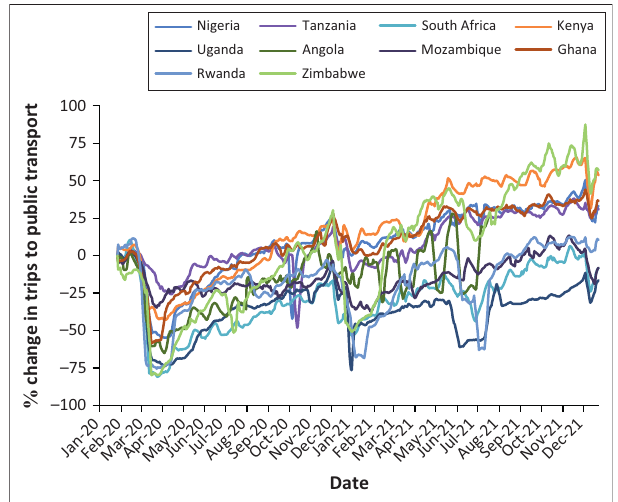
FIGURE 4: Change in trips to transit stations in selected sub-Saharan African countries ( n =